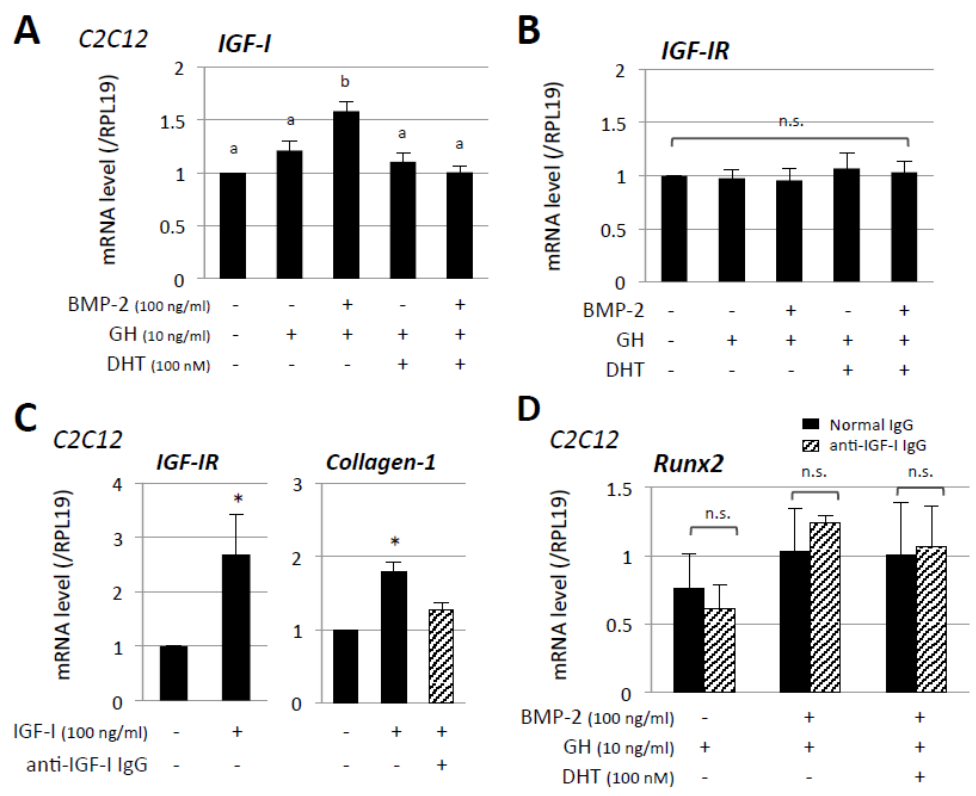
Figure 4. Involvement of IGF-I in osteoblast marker expression induced by BMP-2, androgen, and GH. ( A , B ) C2C12 and MC3T3-E1 cells (2 × 10 5 cells/well) were treated with the indicated concentrations of DHT, GH, and BMP-2 in a serum-free medium. After 48-h culture, total cellular RNA was extracted and mRNA levels of IGF-I and IGF-IR were examined by real-time RT-PCR. The expression levels of target genes were standardized by RPL19 mRNA levels in each sample; ( C ) After C2C12 cells (2 × 10 5 cells/well) had been treated with the indicated concentrations of IGF-I and anti-IGF-I IgG in a serum-free condition for 48 h, total cellular RNA was extracted and mRNA levels of IGF-IR and collagen-1 were examined by real-time RT-PCR. The expression levels of target genes were standardized by RPL19 mRNA levels in each sample; ( D ) BMP-2, DHT and GH were added to the cell culture in combination with either normal or anti-IGF-I IgG (1 µ g/mL) in a serum-free condition for 48 h. The expression levels of Runx2 were determined by real-time RT-PCR and the expression levels of Runx2 mRNA were standardized by RPL19 mRNA levels in each sample. Results in all panels are shown as means ± SEM of data from at least three separate experiments, each performed with triplicate samples. The results were analyzed by ANOVA and the unpaired t -test. For each result within a panel, the values with different superscript letters are significantly different at p < 0.05 ( A , B ). * p < 0.05 vs. control group ( C ). n.s., not